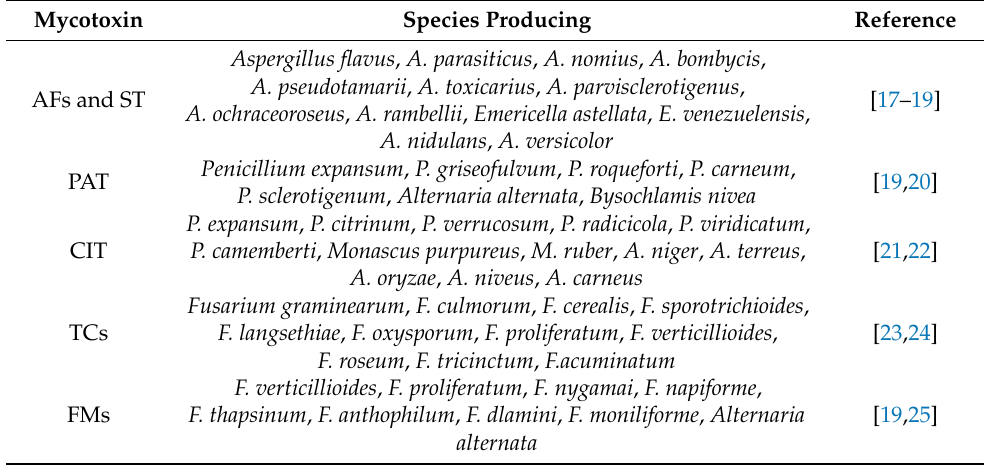
Table 1. Major mycotoxins and their fungal origin.